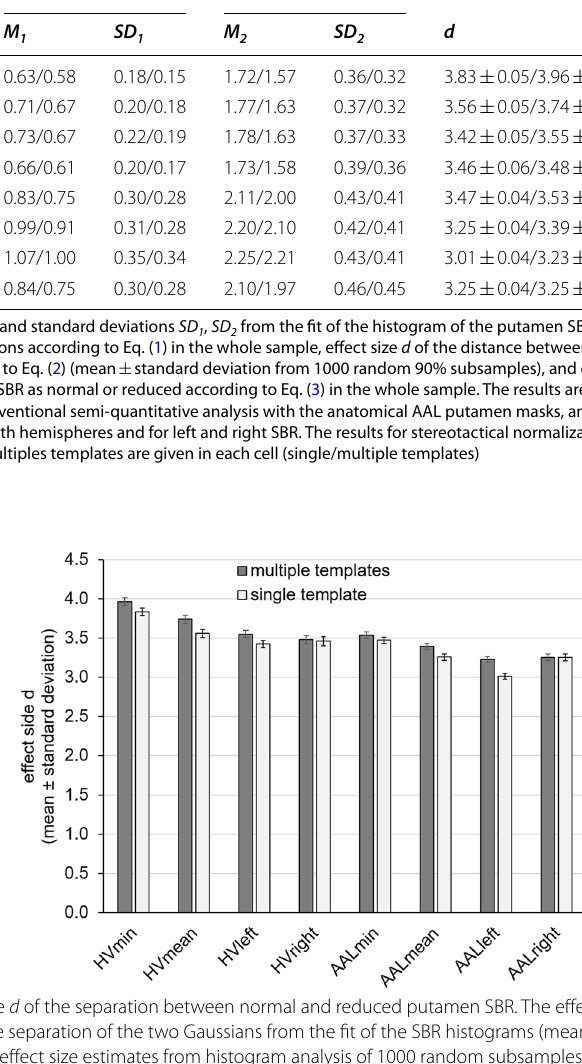
Table 2 Fit of the histogram of the putamen SBR by the sum of two Gaussian functions Single/multiple templates